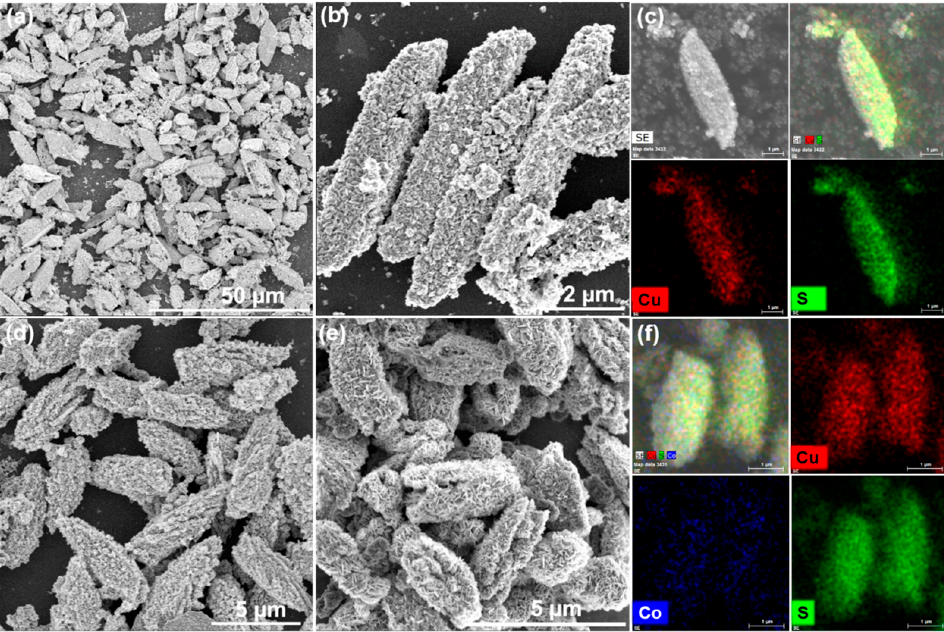
Figure 2. SEM images of copper cobalt sulfides ( a , b ) CuS, ( d ) Co-CuS-1, ( e ) Co-CuS-2, and the EDX mapping element distribution of ( c ) CuS, ( f ) Co-CuS-2.